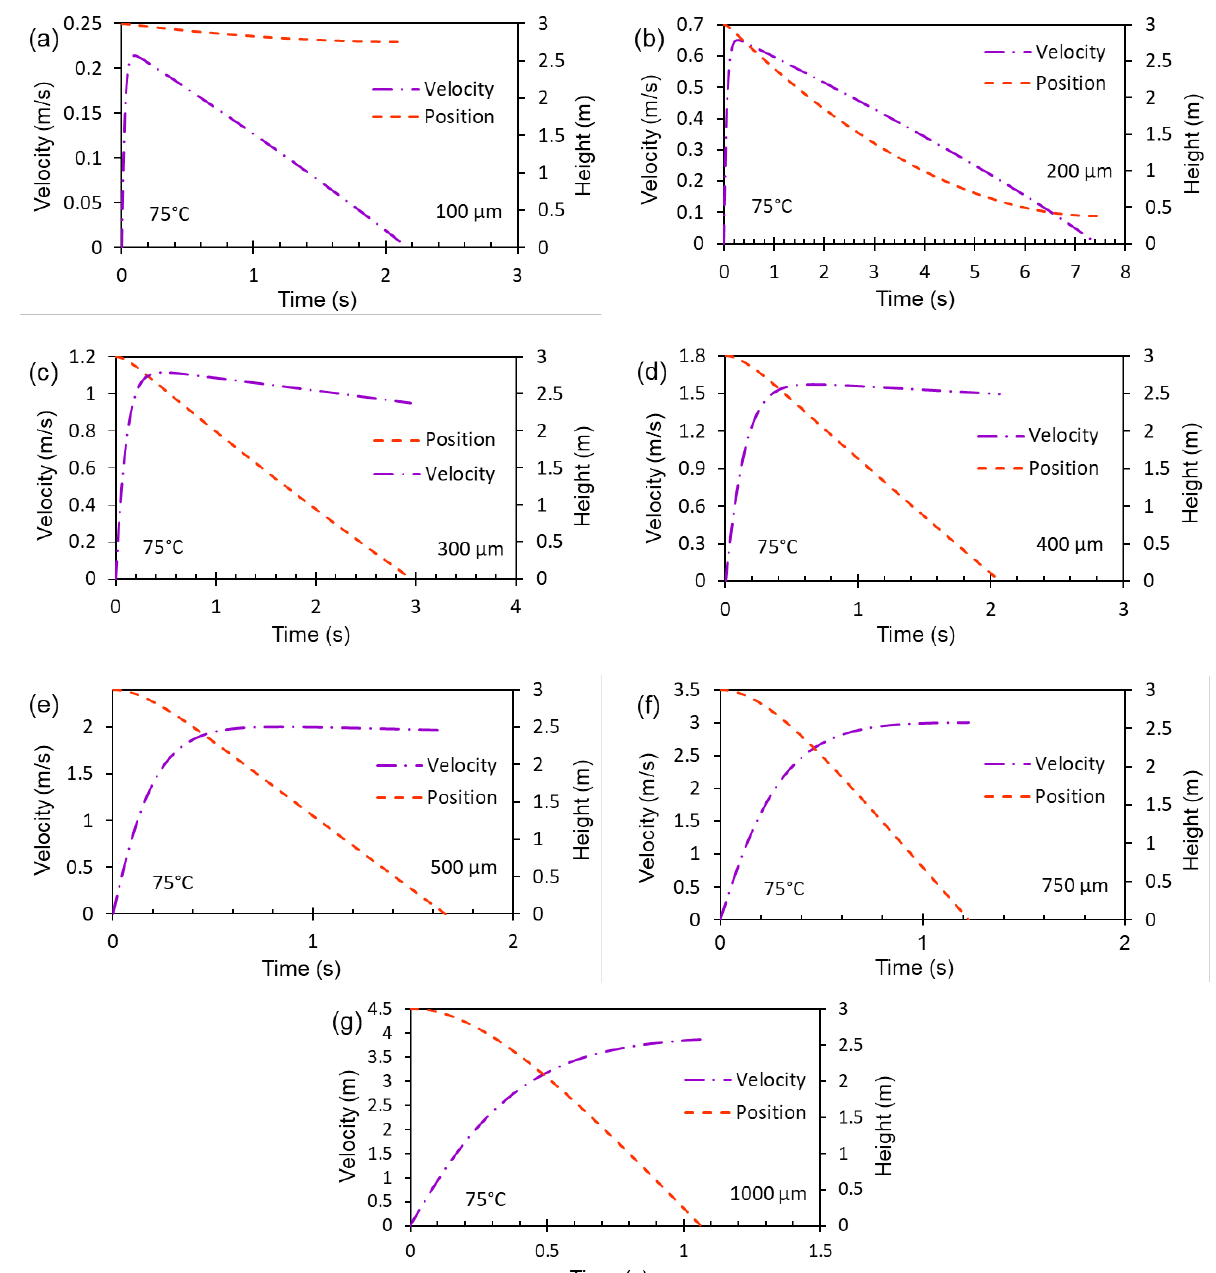
Figure 6. Velocity and position history of droplets with different initial drop sizes for condition 1 (75 °C); ( a ) 100 µm; ( b ) 200 µm; ( c ) 300 µm; ( d ) 400 µm; ( e ) 500 µm; ( f ) 750 µm; and ( g ) 1000 µm.